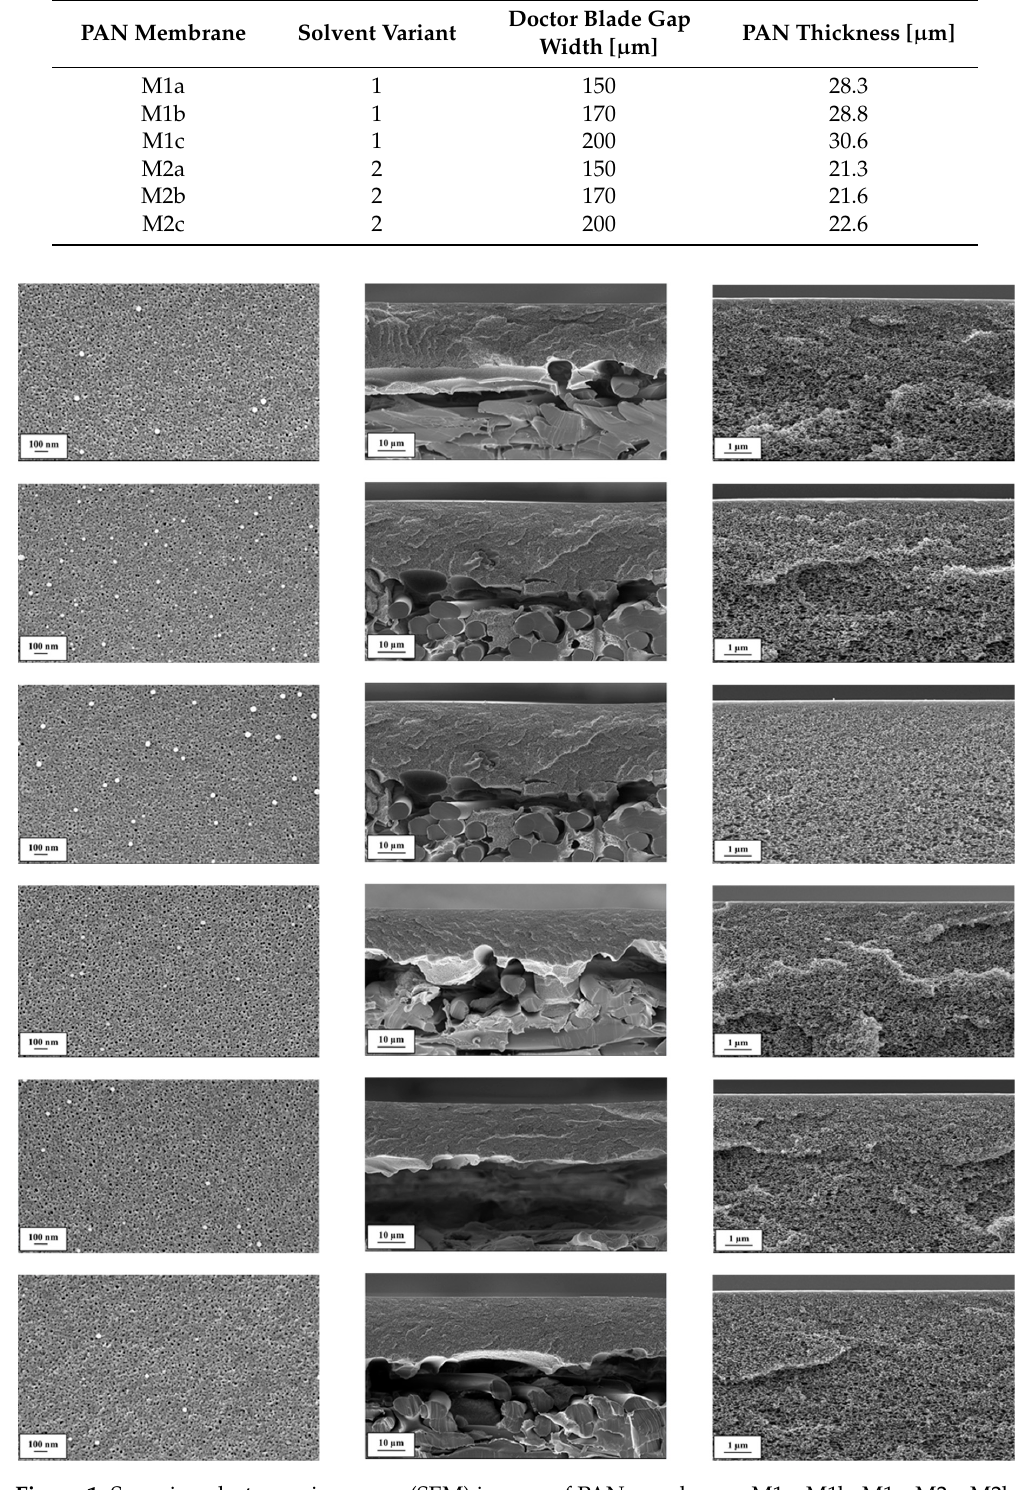
Table 2. Polyacrylonitrile (PAN) membranes used as support for supported ionic liquid membranes (SILMs): differences in preparation conditions and resulting porous layer thickness.